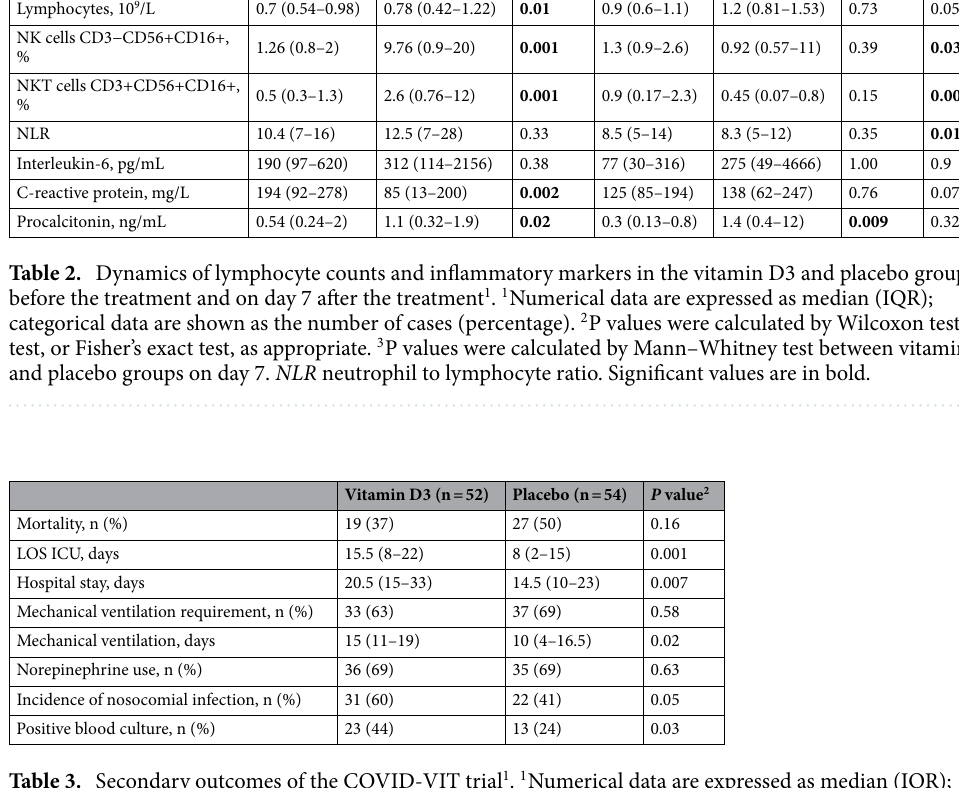
Table 3. Secondary outcomes of the COVID-VIT trial 1 . 1 Numerical data are expressed as median (IQR); categorical data as number of cases (percentage). 2 P values were calculated by Mann–Whitney U test, χ 2 test, or Fisher’s exact test, as appropriate. LOS ICU length of stay in the intensive care unit; 3 N is reference